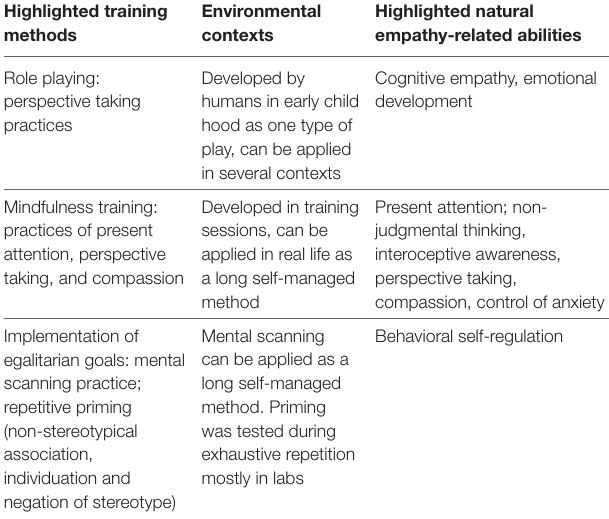
Highlighted training